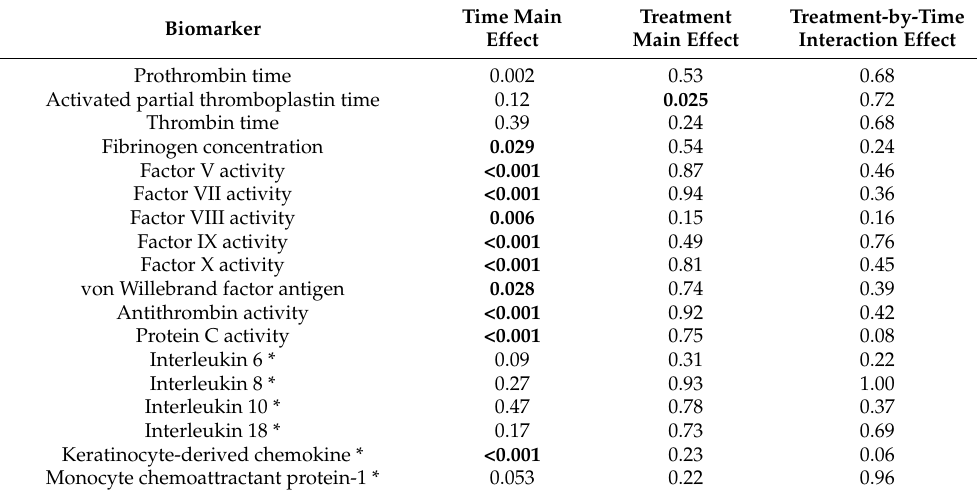
Table 2. Fixed effect p -values for linear mixed effects models analyzing coagulation and inflammation biomarkers over time in dogs randomized to receive 6% hydroxyethyl starch 130/0.4 or Hartmann’s solution. These models contained a random variance of dog, nested within treatment, and no additional covariates. Significant results ( p < 0.05) are in